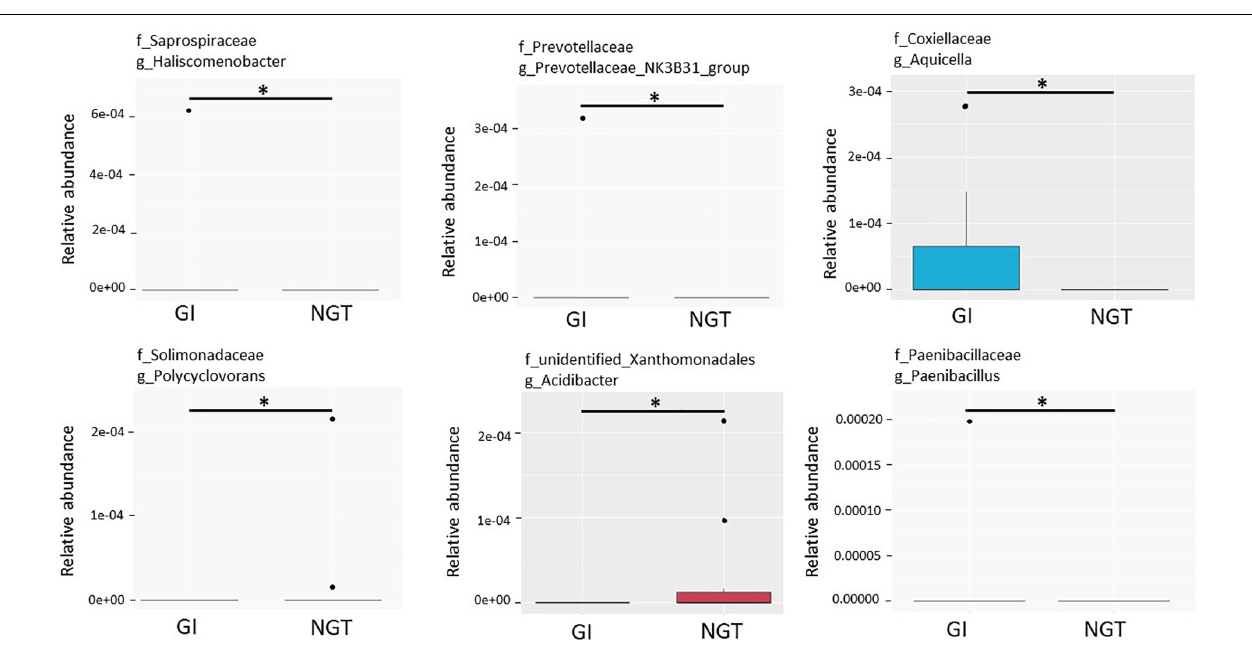
FIGURE 5 | Box plots showing the top six relative abundance of the genera that significantly differed between GI and NGT groups using metastats corrected by the Benjamini–Hochberg method. The box represents the interquartile range (IQR), the inside line represents the median, the whisker represents values within 1.5 × IQR of the first and third quartile, and the circle represents the outliers. ∗ Genera with q -value < 0.05 were considered statistically significant. GI, glucose intolerance; NGT, normal glucose